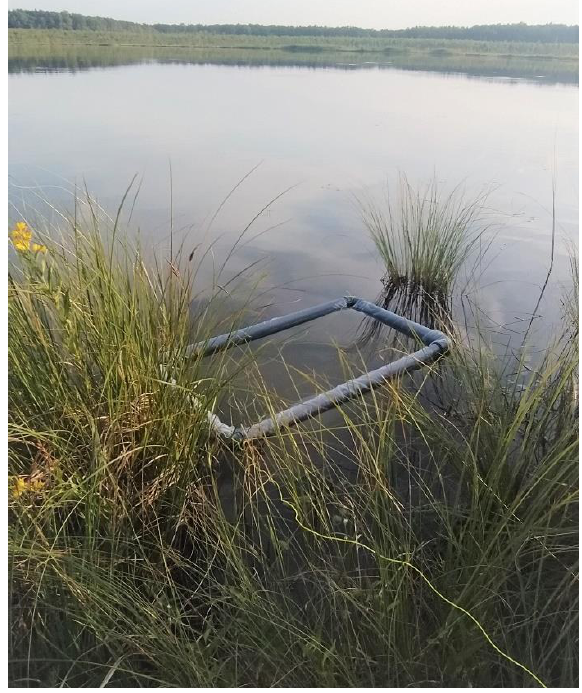
Figure 5. A net for monitoring of Aldrovanda vesiculosa plants in a natural lake.